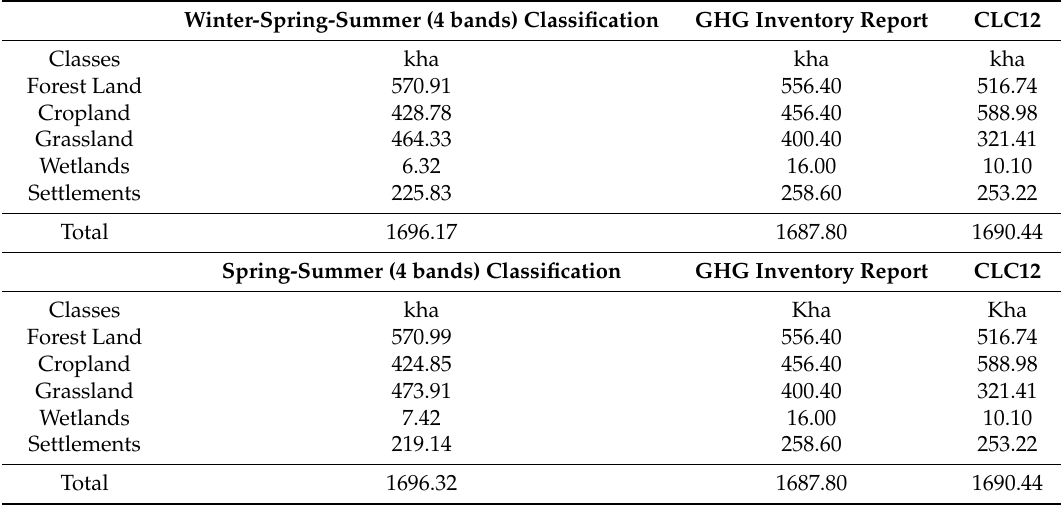
Table 6. Comparison of land areas in kha from the three best classification products (winter-spring- summer with 10 bands, spring-summer with 4 bands, and summer with 10 bands) to the Greenhouse Gas (GHG) Inventory Report and the Corine Land Cover 2012. ( a ) The winter-spring-summer classification with 4 bands (best OA reached, 92.6%); ( b ) the spring-summer classification with 4 bands (second-best OA, 91.5%); ( c ) the summer classification with 10 bands (third-best OA, 91.4%). All the land areas were within the same range except the wetlands, which varied from 2.86